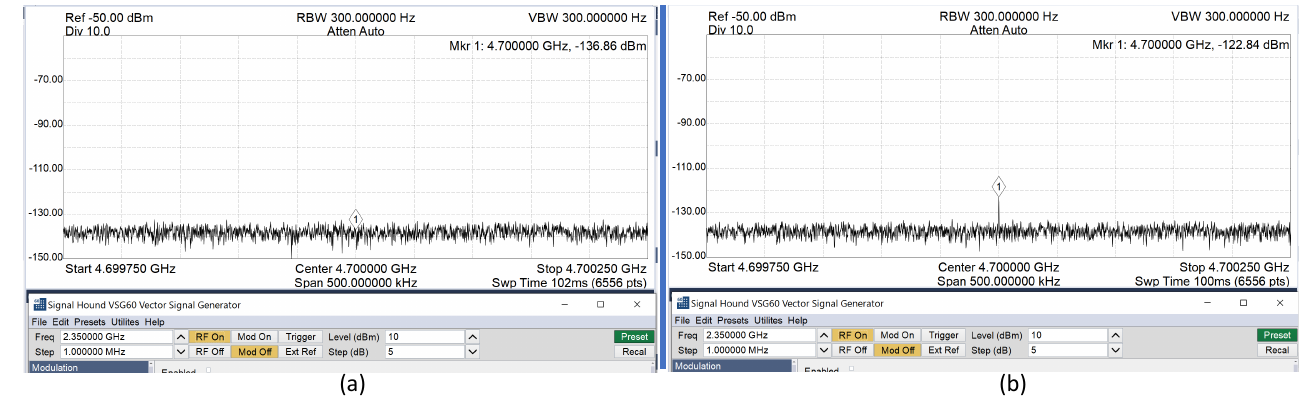
Figure 5. Screenshot of the spectrum plot for the second harmonic. ( a ) shows the spectral plot when there are no devices present in the radar’s path. ( b ) shows the harmonic response of device e